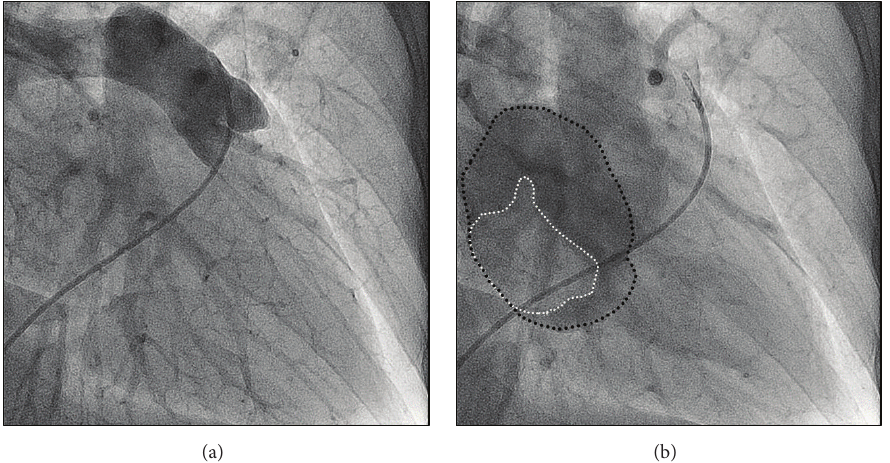
Figure 2: (a) Pulmonary angiography. (b) During the late left atrial filling (black dotted line) by the dye contrast, the negative image corresponding to the tumoral mass presence was clearly noted (white dotted